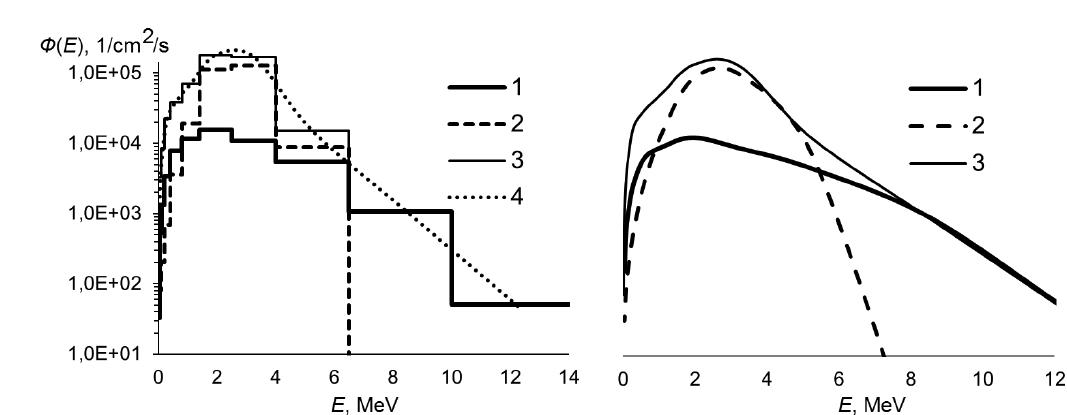
with a mass of 5.65 kg: 1 – spontaneous fission, continuous 2